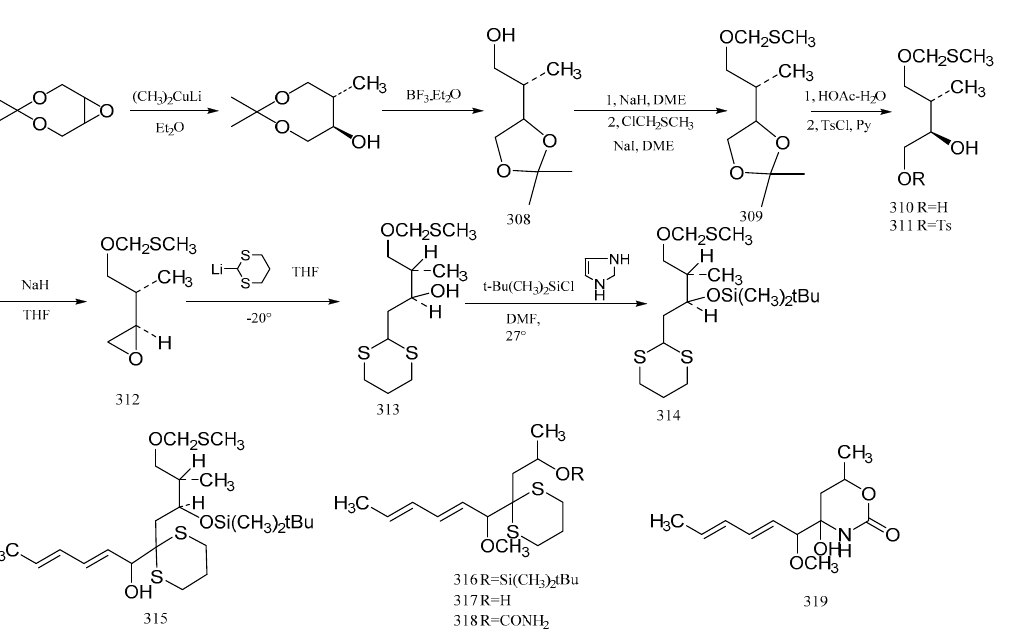
Figure 13. The production of compound 314 and its derivatives.